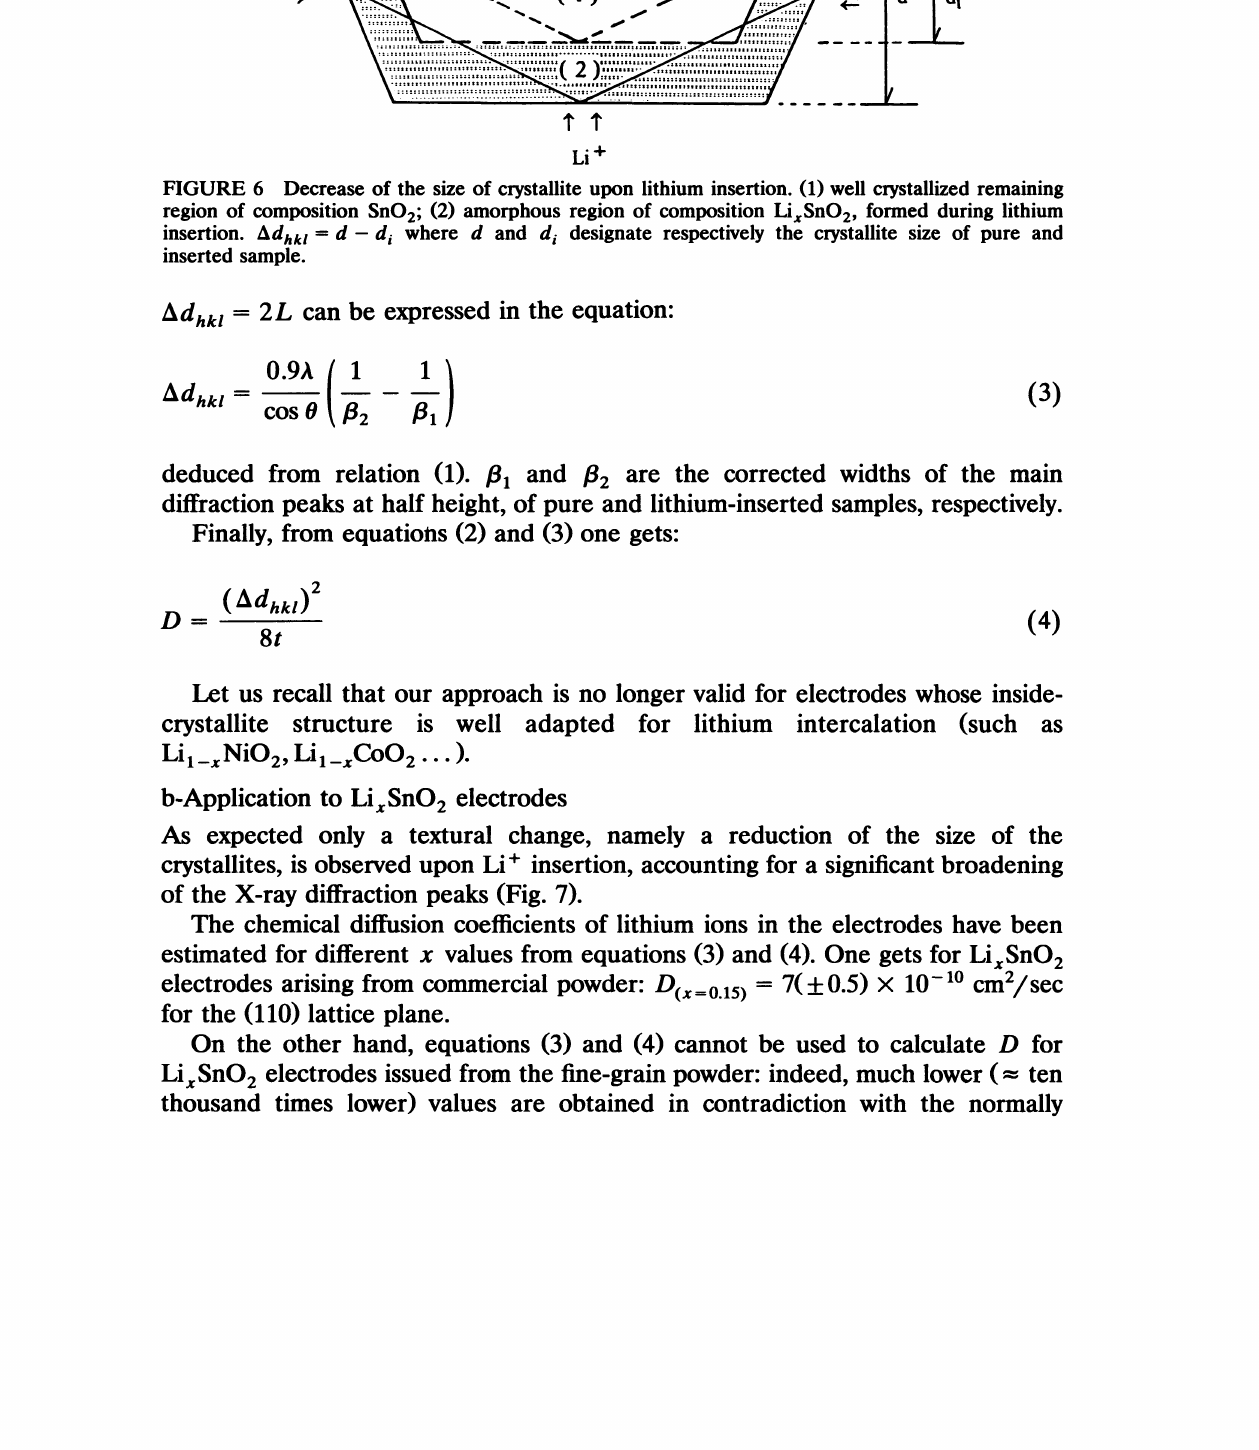
formed during lithium 2,